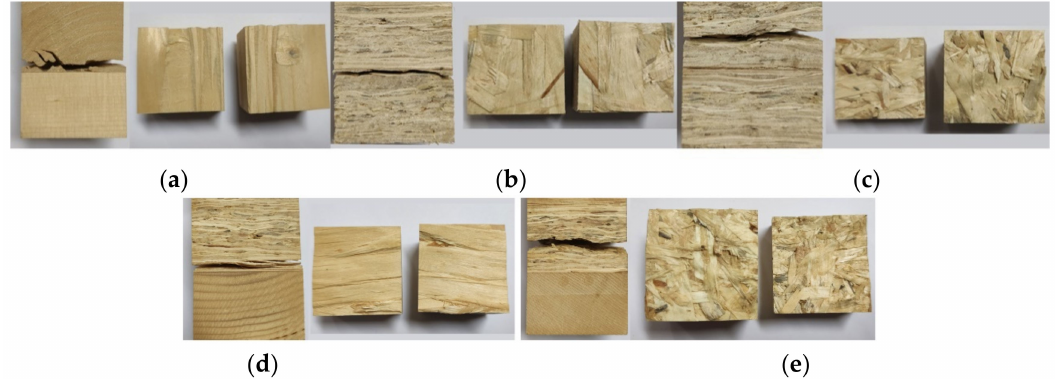
Figure 6. Typical failure modes of CLT and HCLT specimens during block shear tests.